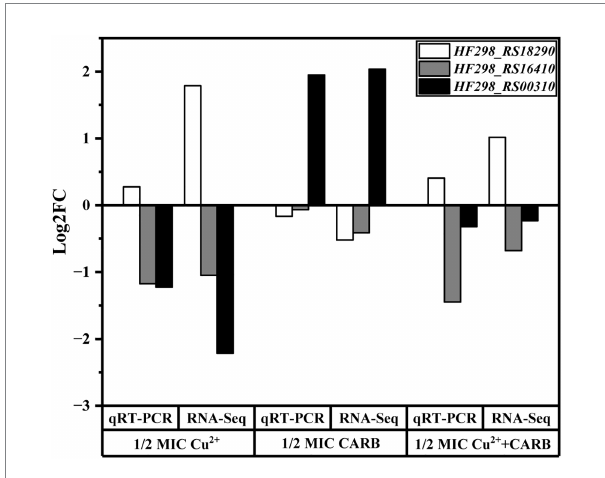
FIGURE 10 Analysis of differential genes expression levels between RNA-Seq and